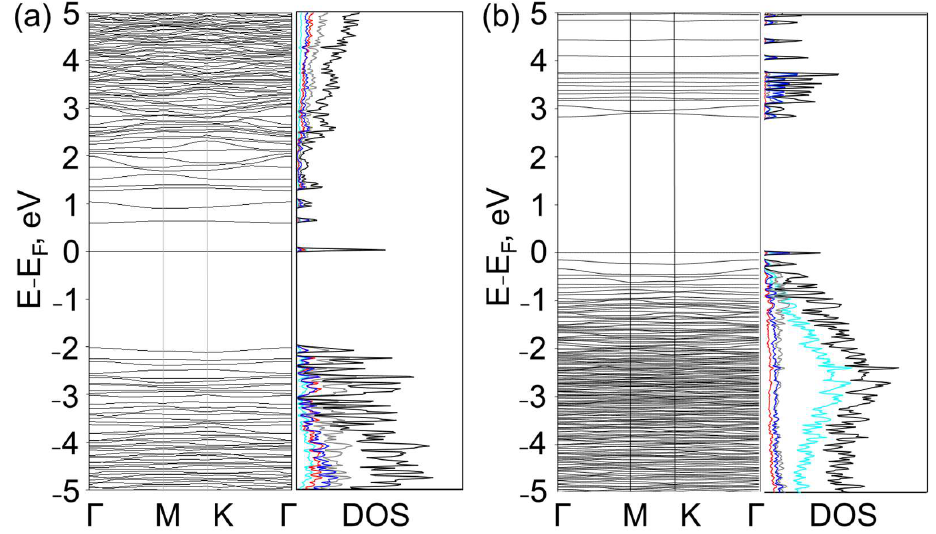
Figure 4. Band structures and densities of states of hydrogenated ( a ) and fluorinated ( b ) diamane-like G/BN structures with θ = 10.9 ◦ with C-B bonds in the AA-stacked area. Cyan, yellow, red, blue, gray and black lines correspond to H, F, B, C, N and total DOS, respectively.